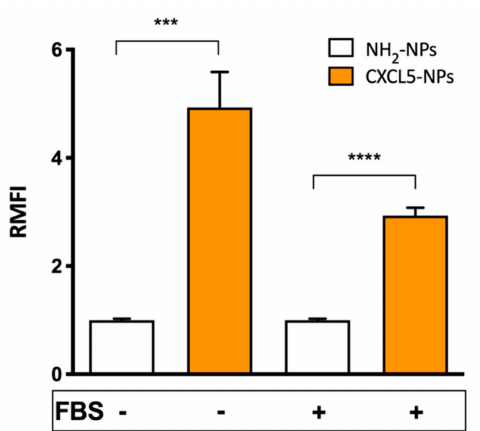
Figure 4. Cellular uptake of NPs. Flow cytometry evaluation of 50 µ g / mL NPs internalization in THP-1 cells. The bars represent the relative median fluorescence intensity (RMFI) of at least three independent experiments ± standard error of the mean (SEM). **** p < 0.0001 *** p < 0.0005.